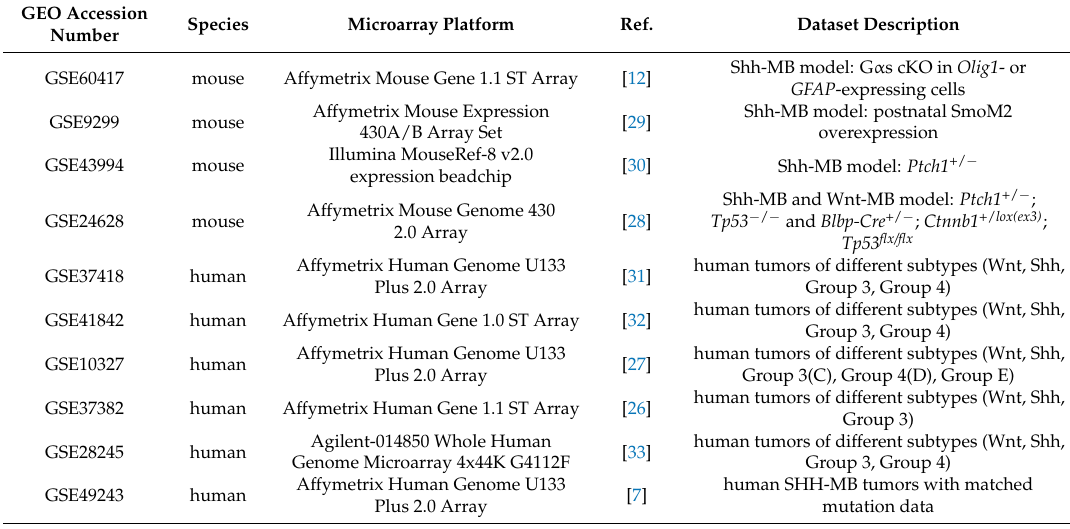
Table 1. Microarray datasets used in transcriptomic